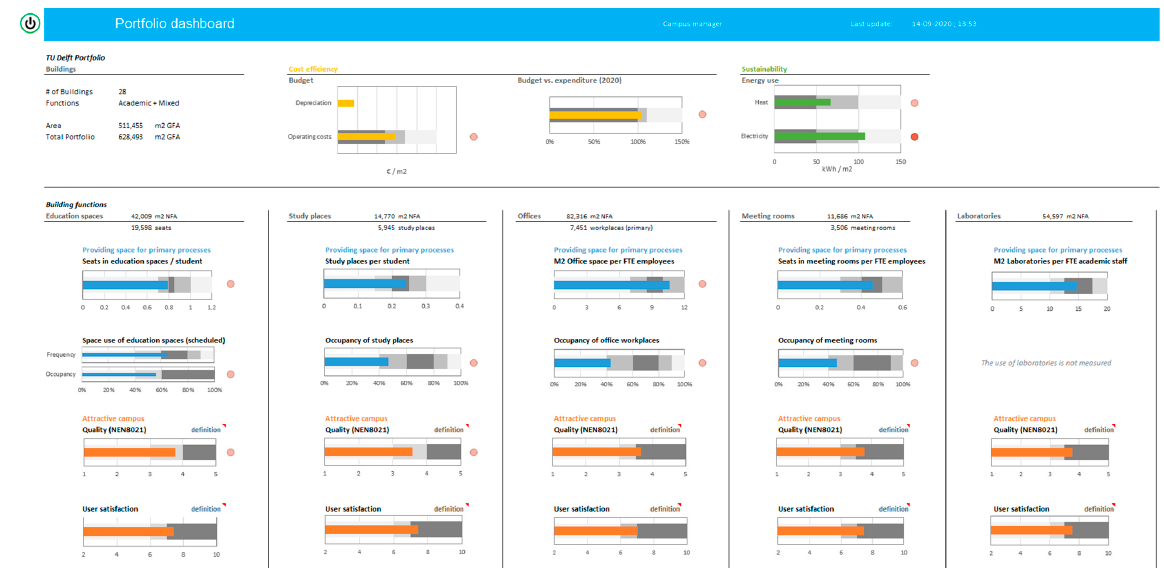
Figure 8. Main dashboard ‘Portfolio TUD’ (tested in workshop 2).